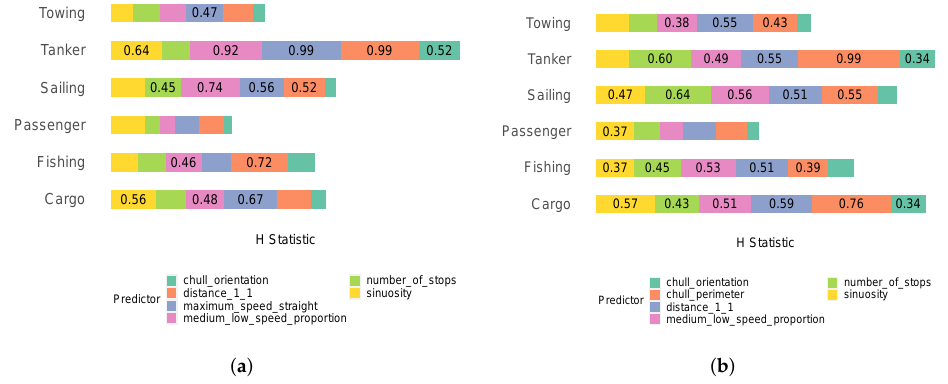
Figure 13. ( a ) The two-way H test results for chull_perimeter across all classes; ( b ) the two-way H test results for maximum_speed_straight across all